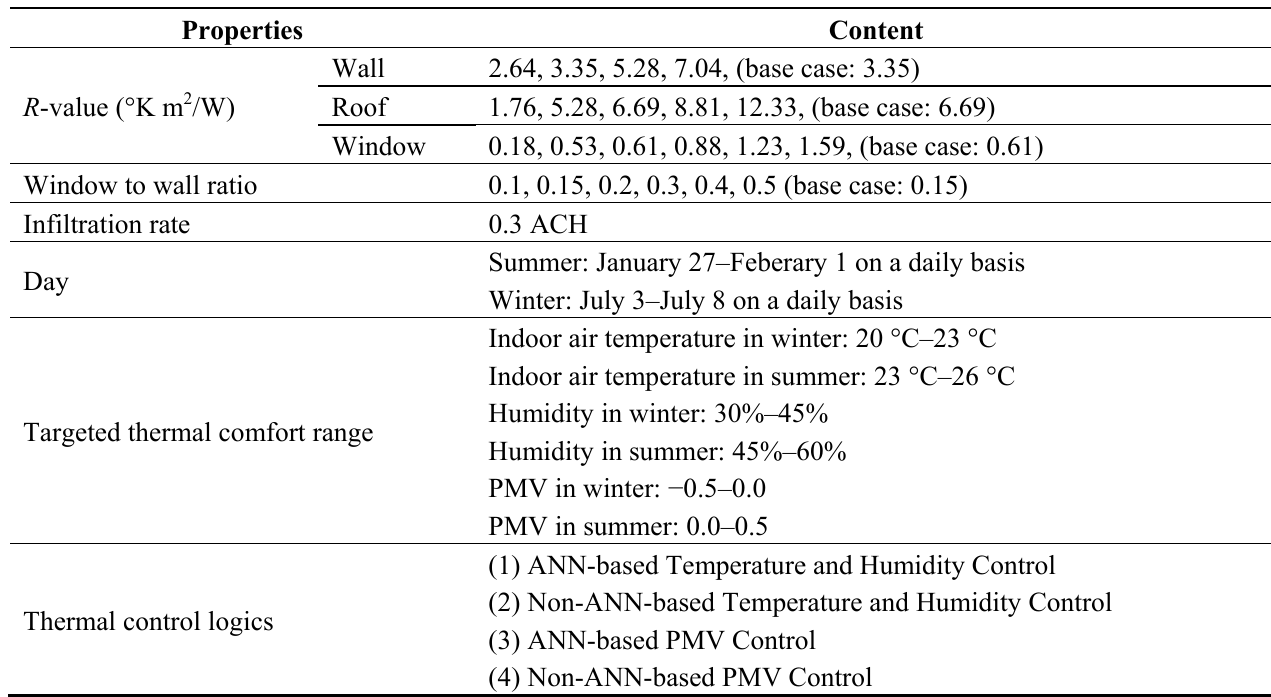
Table 3. Simulation conditions for performance test.